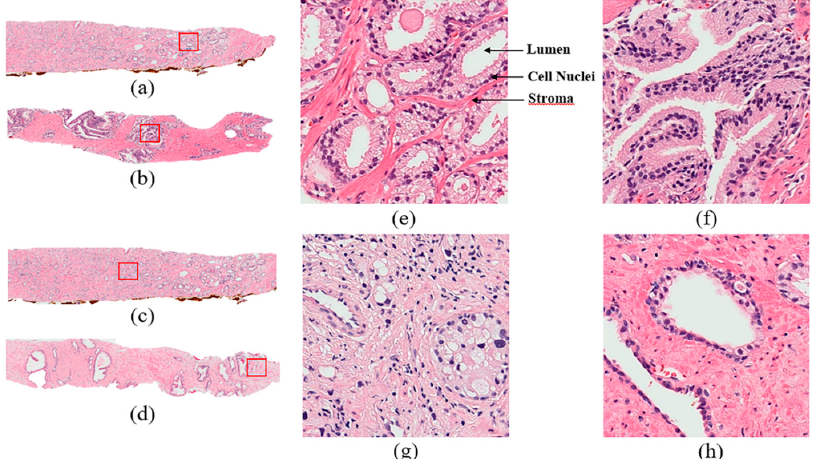
Figure 1. Microscopic biopsy images stained with Hematoxylin and Eosin (H&E) compound; ( a – d ) whole slide tissue images of Grade 3, Grade 4, Grade 5, and Benign; and ( e – h ) the regions of interest (ROIs) taken from whole-slide images ( a ), ( b ), ( c ), ( d ) respectively. The dark blue is the cell nucleus, pink is the stroma, and white is the lumen.